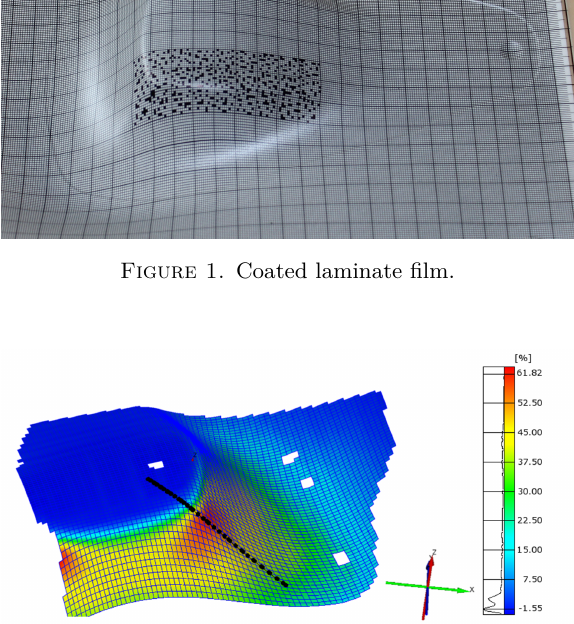
Figure 2. Strain field on the thermoformed laminate film.